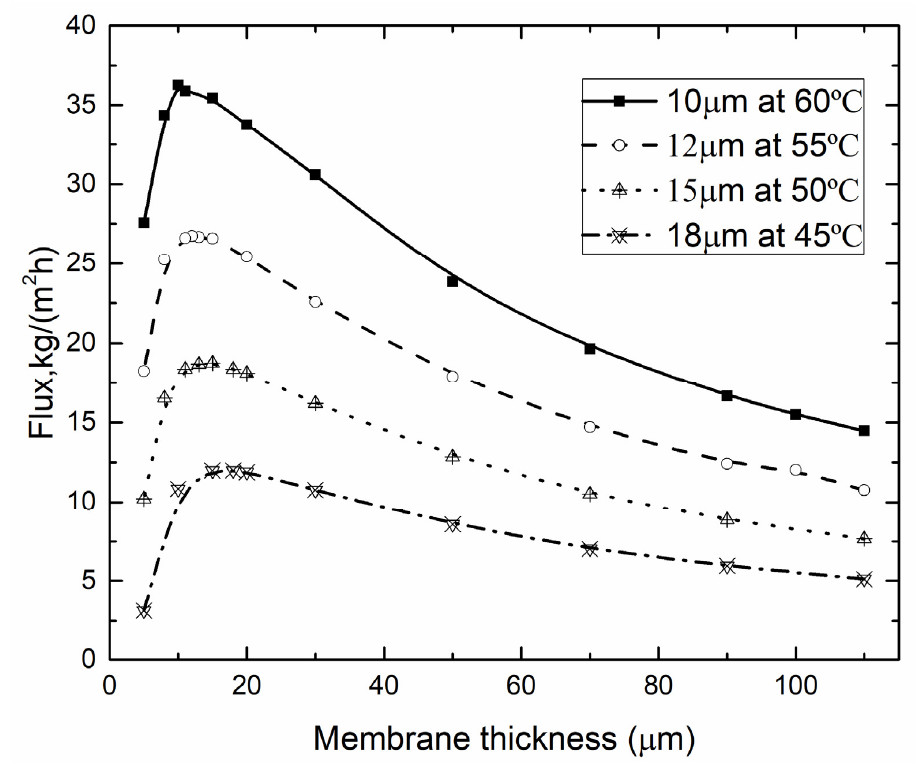
Figure 13. Optimal membrane thickness for different T f ( T p = 25 °C, v f , v p = 0.15 m/s, c f = 24.2 wt.%, GVHP).